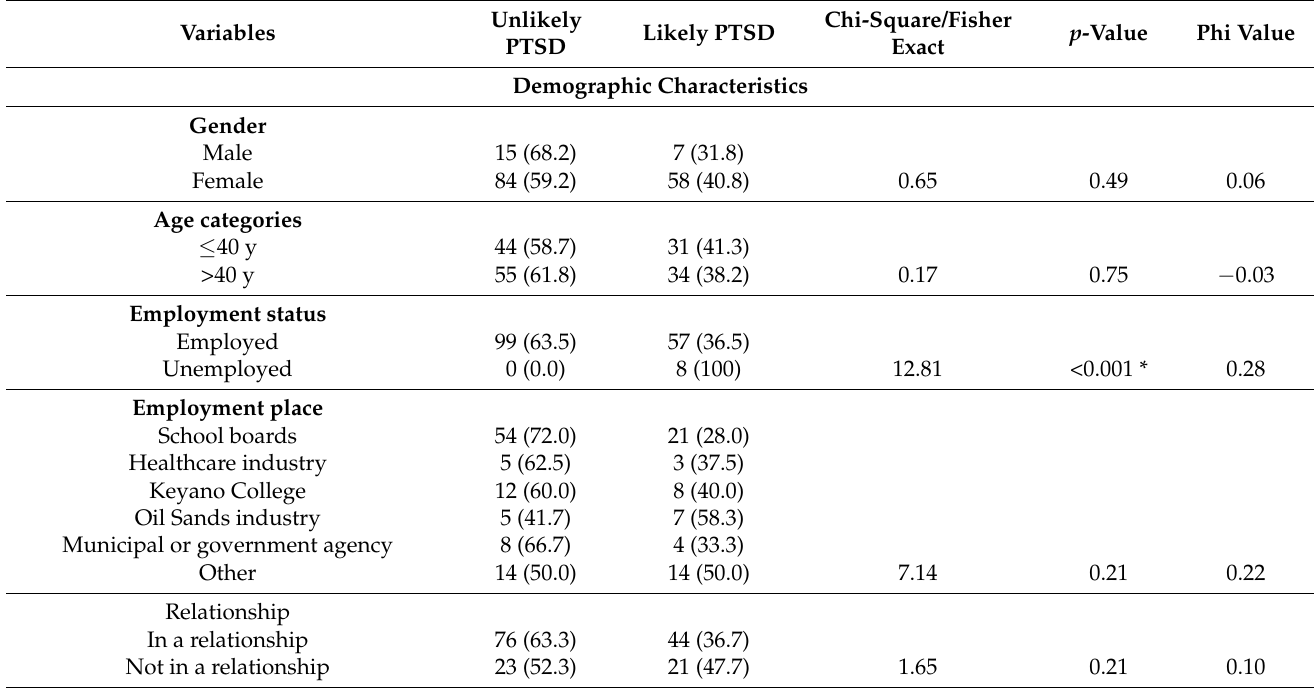
Table 2. Chi-squared test of association between demographic, clinical antecedents & likely